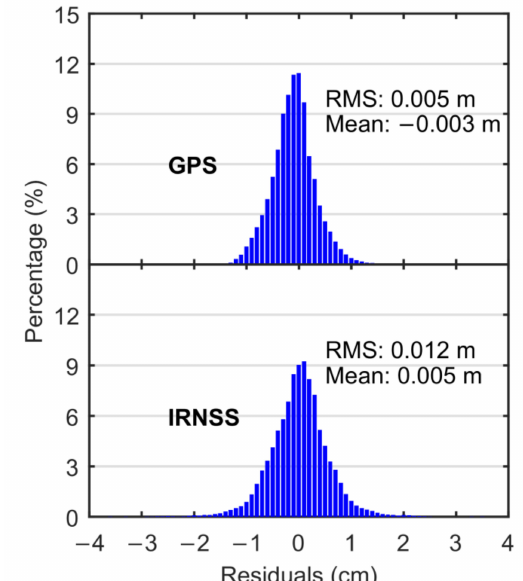
Figure 16. Distribution of carrier phase observation residuals of ambiguity-fixed solutions derived from GPS/IRNSS integrated short-baseline RTK for GPS and IRNSS